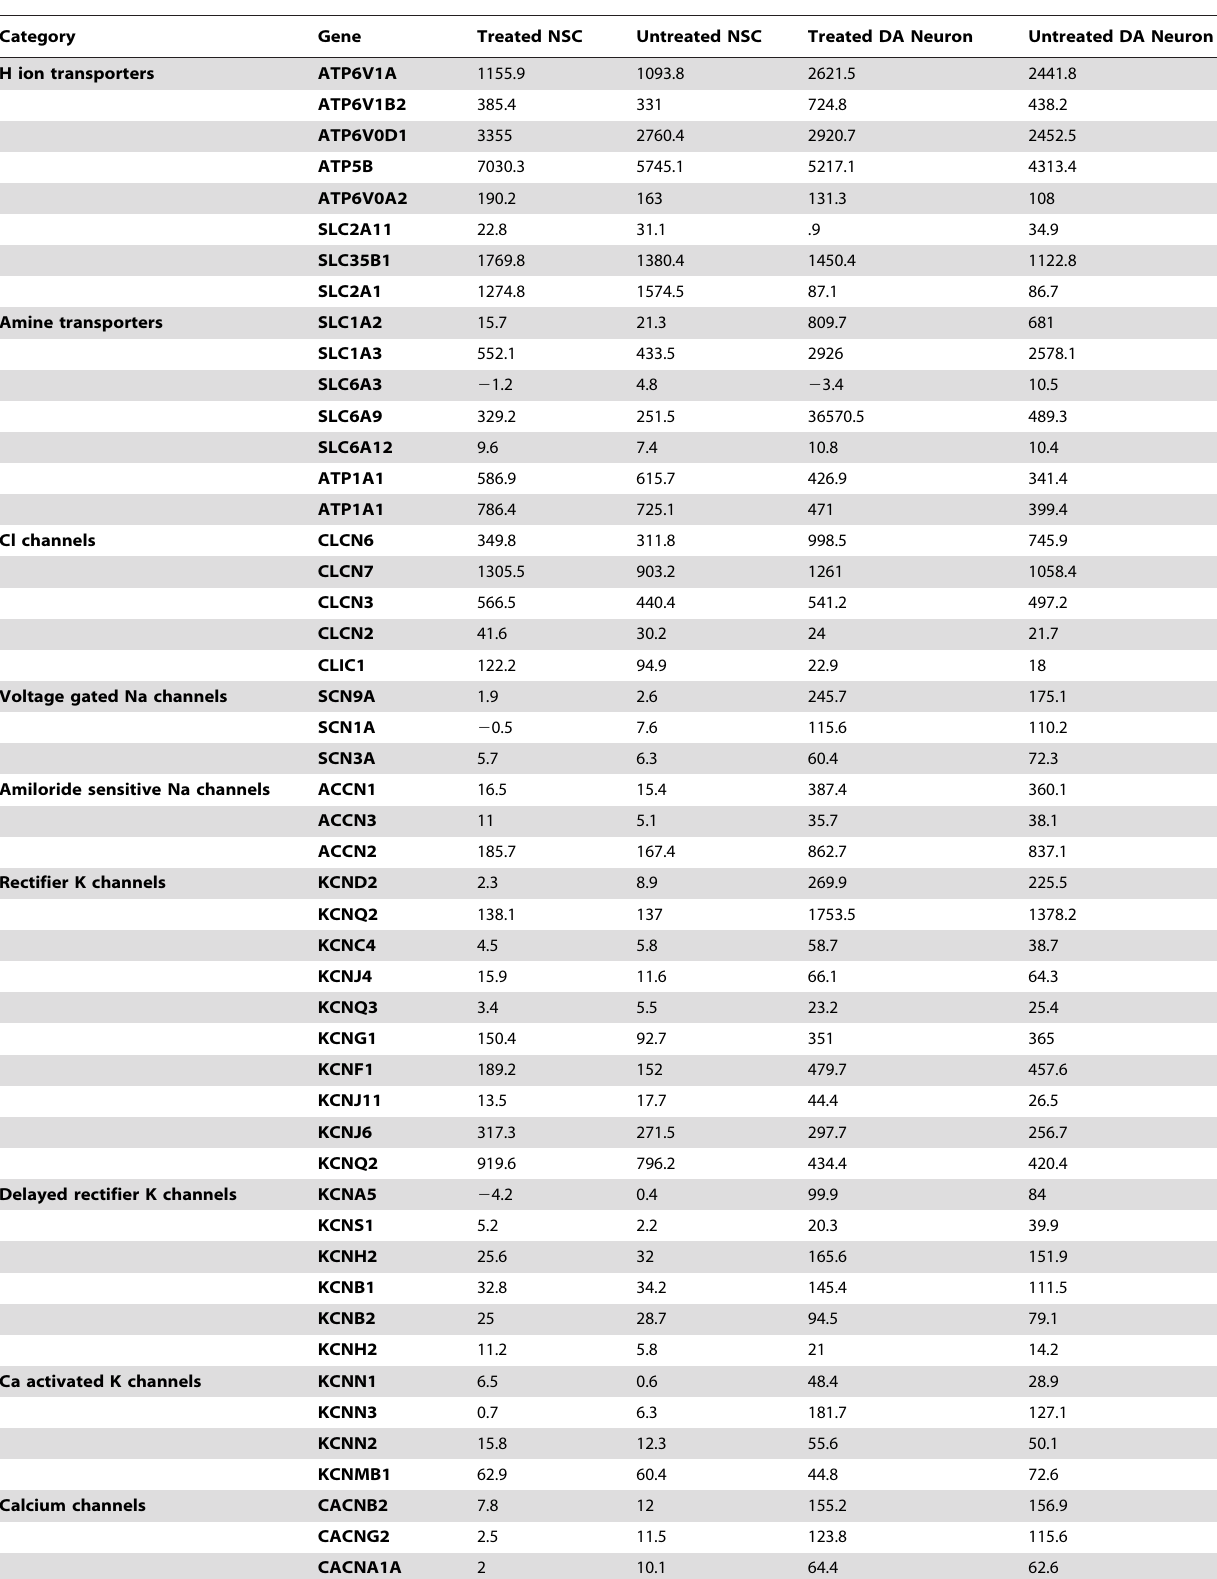
Table 1. Ion channel gene expression in NSCs with and without amiodarone HCl treatment compared to similarly treated dopaminergic